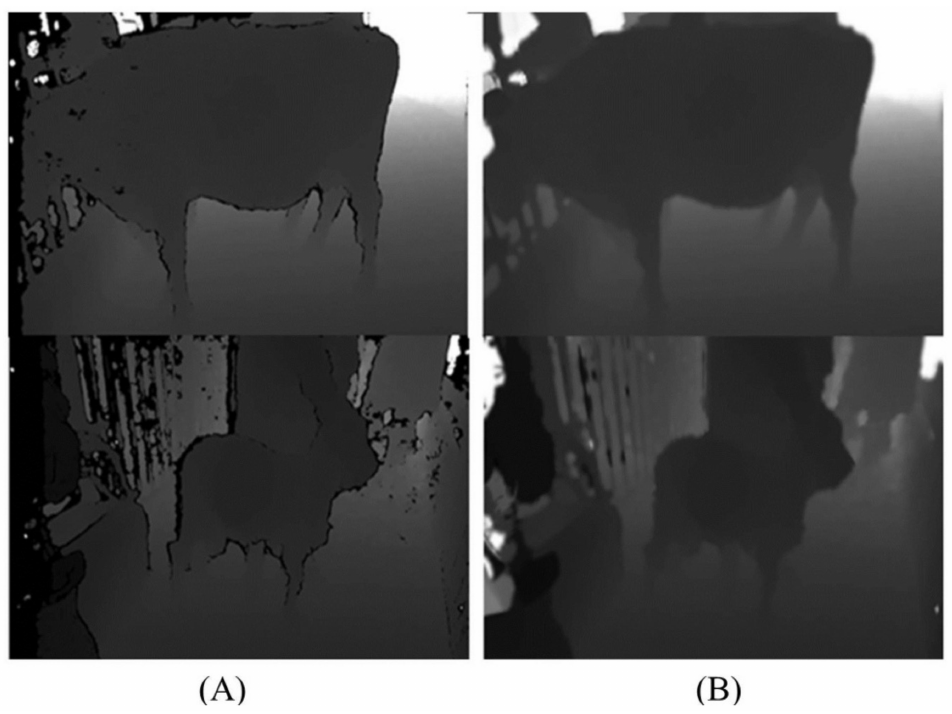
Figure 5. Depth image restoration: ( A ) is the original depth image; ( B ) represents the reconstructed depth image. Texture copy artifacts and depth discontinuities are significantly